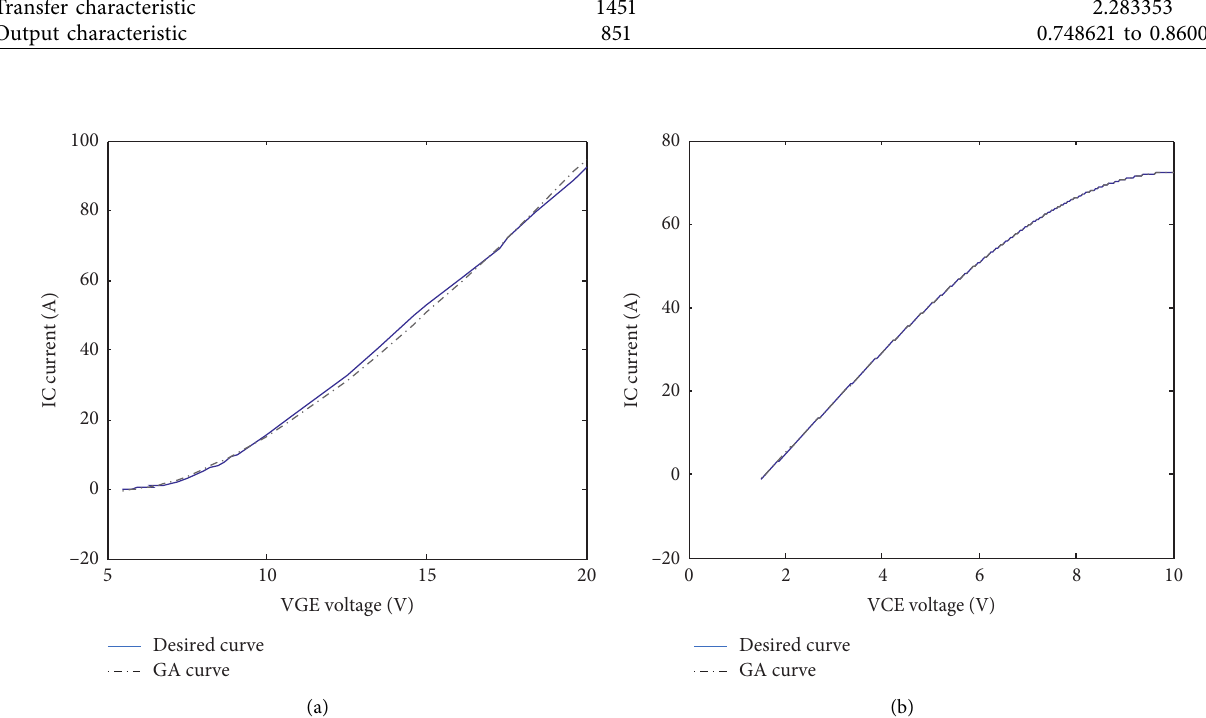
Figure 8: Convergence between manufacturer characteristics and GA curves giving optimal parameters. (a) Transfer characteristic. (b) Output characteristic.